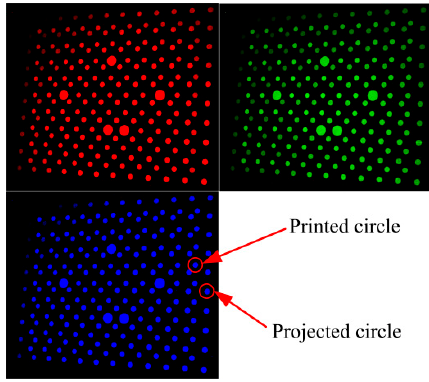
Figure 3. The distances between different printed color circles: ( a ) the relative distances from the red Figure 2. Captured color circles images. Figure 2. Captured color circles images. printed circles to the blue ones; ( b ) the relative distances from the green printed circles to the blue ones.